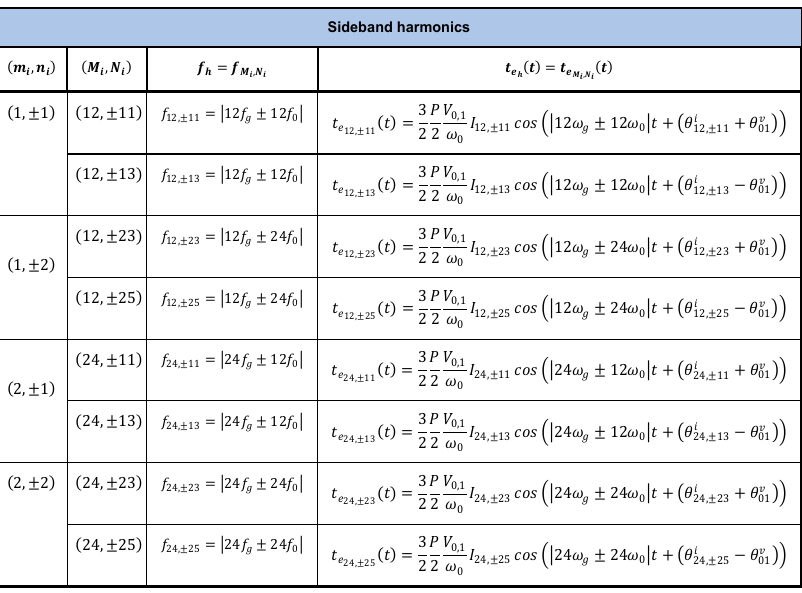
Figure 8. Harmonic families in a 12/12-pulse LCI system: sideband families.